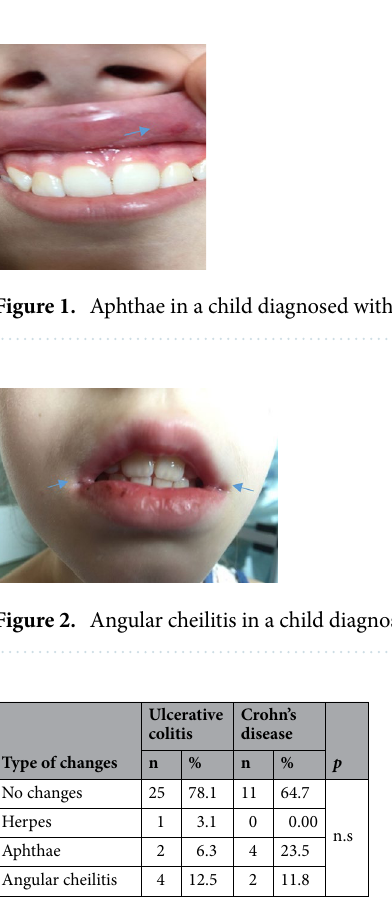
Table 5. Characteristics of changes in the oral mucosa in the study